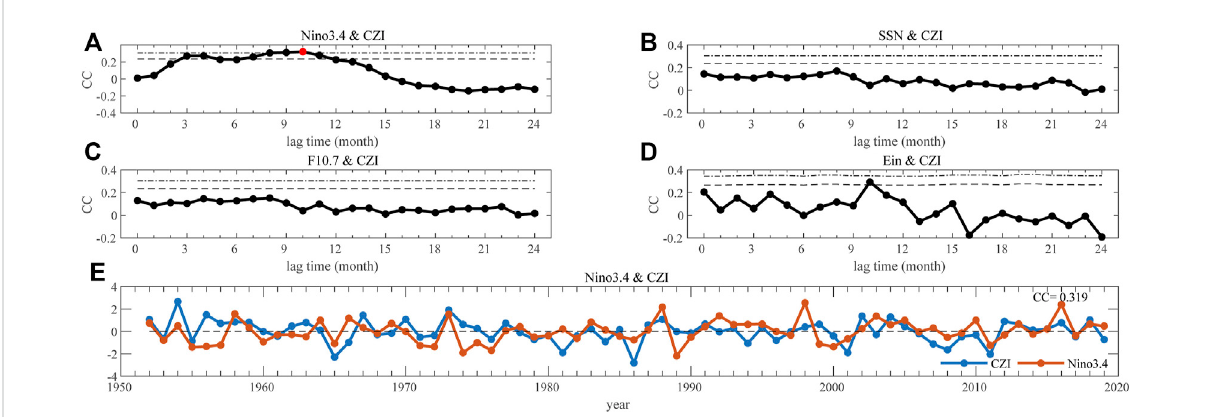
FIGURE 7 Pearson correlation coef fi cients ( CC ) between precipitation in June-July and other indices by considering the time-lagged effect. (A) Niño3.4 (B) SSN, (C) F10.7, and (D) E in . The black dashed (dot-dashed) lines denote the 95% (99%) con fi dence level. The red dots denote the most statistically signi fi cant situation. (E) Normalized SSN (red, 10 months ahead) and the CZI (blue).